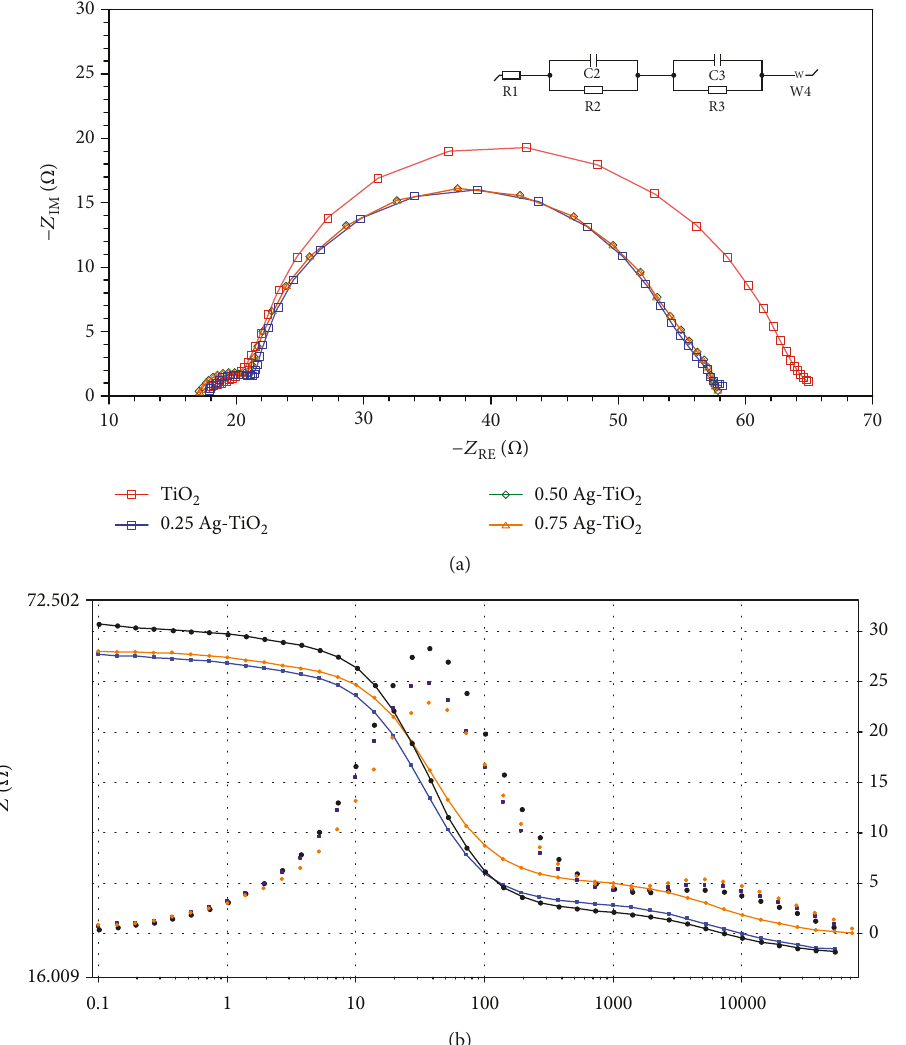
and TiO -P25. 2 2